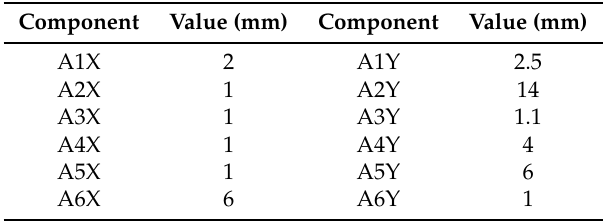
Table 1. Dimensions of the proposed unit monopole